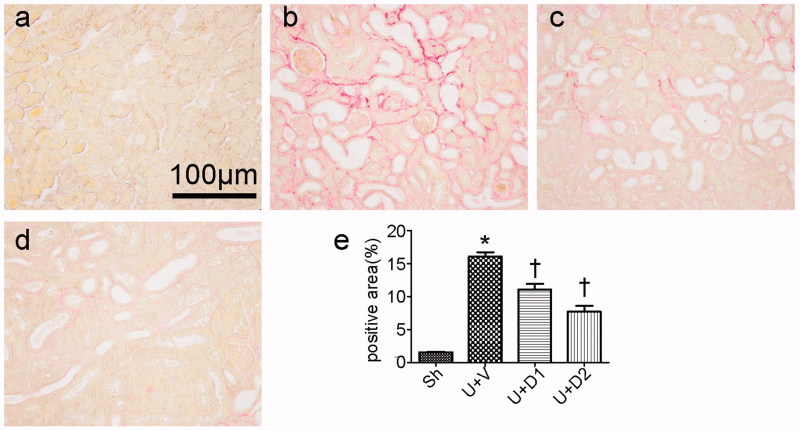
Representative photographs of PSR staining. (a) Sham group (Sh); (b) UUO plus vehicle group (UUO + V); (c) UOO plus 50 mg/kg UA (UUO + D1); (d) UOO plus 100 mg/kg UA (UUO + D2). (e) Semiquantitative analysis of positive area. *p < 0.05 VS. Sh, †p < 0.05 VS. U + V. Scale bar = 100 μm.